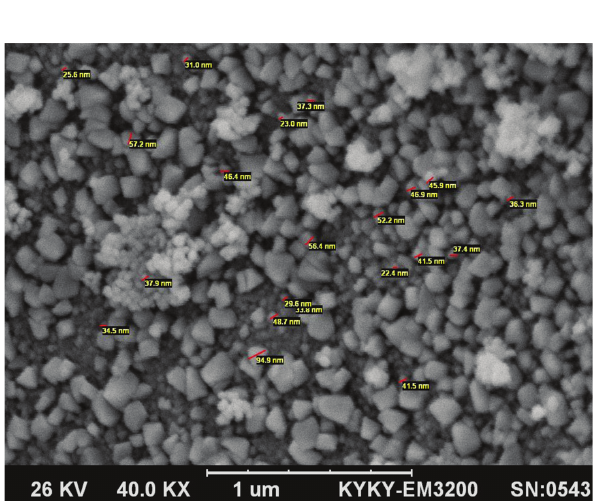
Figure 2: XRD pattern of NiCr 2 O 4 calcined at 1,073 K for 4 h.